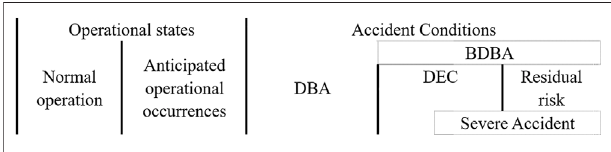
FIGURE 5 | Plant states considered residual